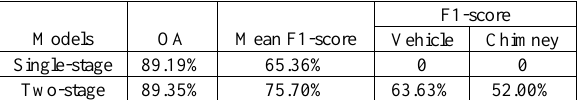
Table 2 . Performance comparison between the proposed two- stage approach and the single-stage segmentation.